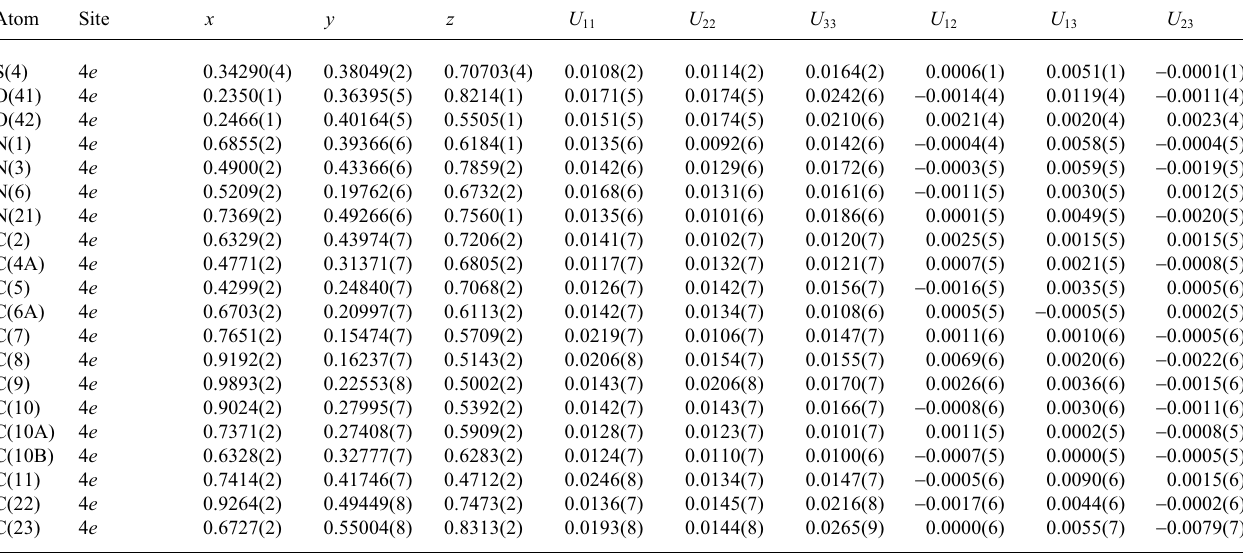
Table 3. Atomic coordinates and displacement parameters (in Å 2 ).